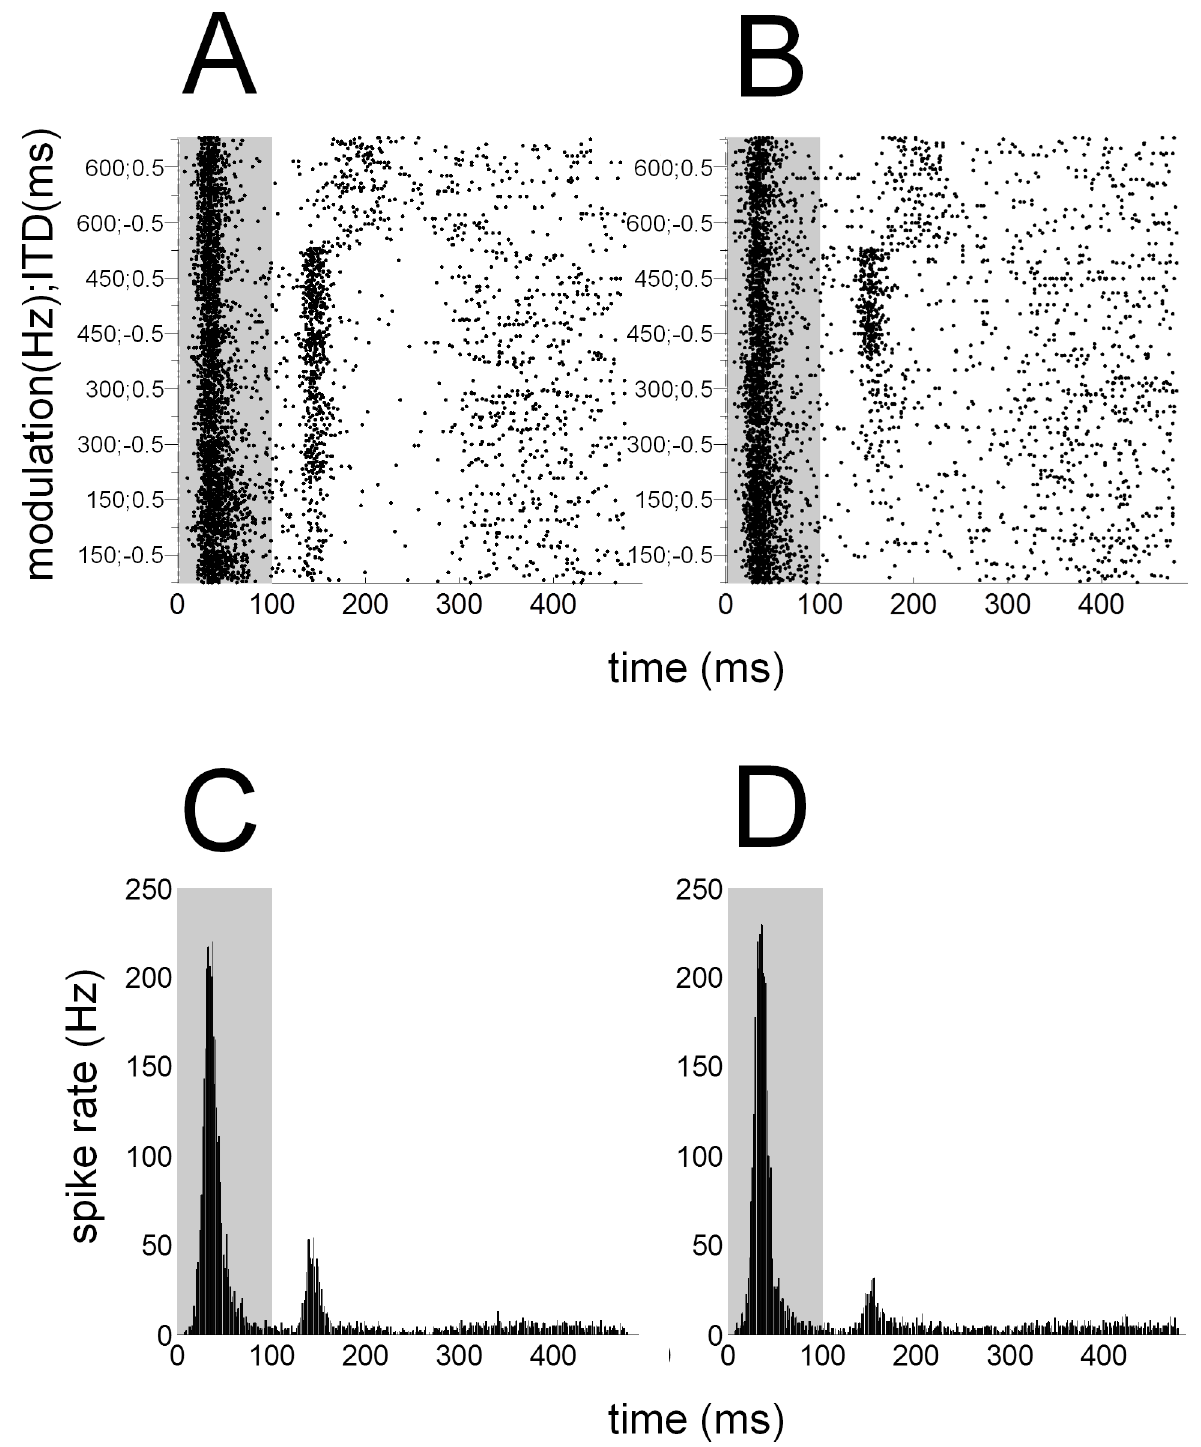
Figure 5. Cortical responses from a normal-hearing animal. Example of dot-raster plots (A & B) and post-stimulus time histograms (C & D) for an individual unit with a significant response to both SAM (A & C) and HWR tones (B & D). The stimulus duration is represented by the light grey bar. Dot-raster plots (A & B) show spike timing as black dots, with time and stimulus plotted on the x- and y-axes, respectively. Along the y-axis the different stimuli are arranged from higher- to lower-frequency of modulation and from positive to negative ITDs.